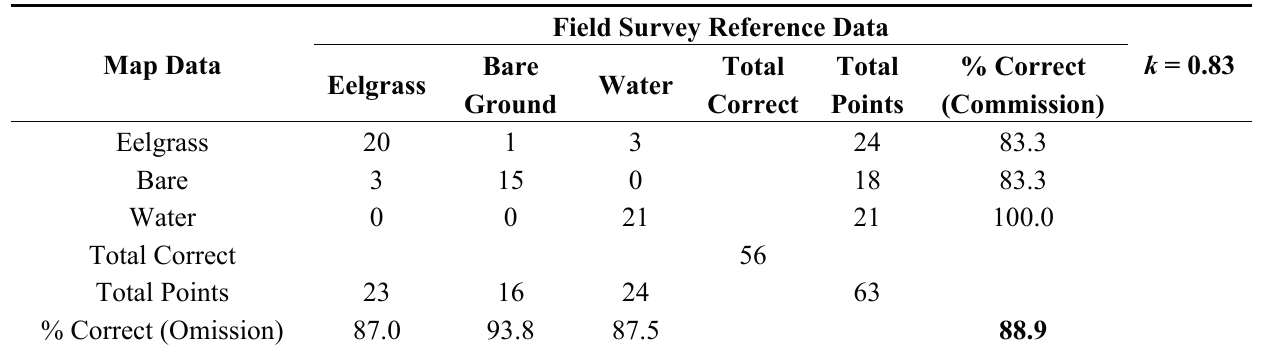
Table A11. Final product for classification of habitats in Littlejohn Lagoon.